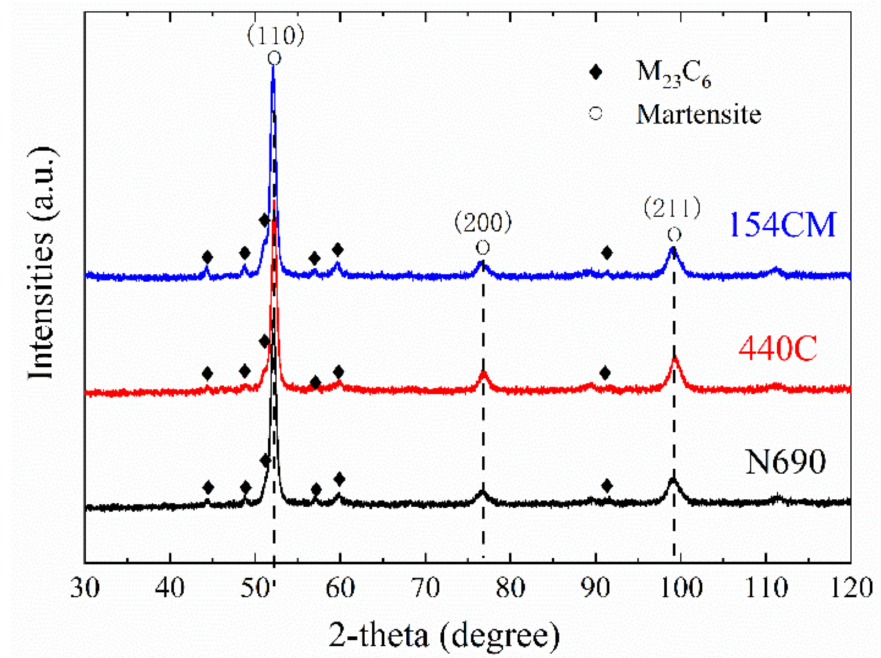
Figure 6. XRD patterns of the martensitic stainless steels for knife blade.